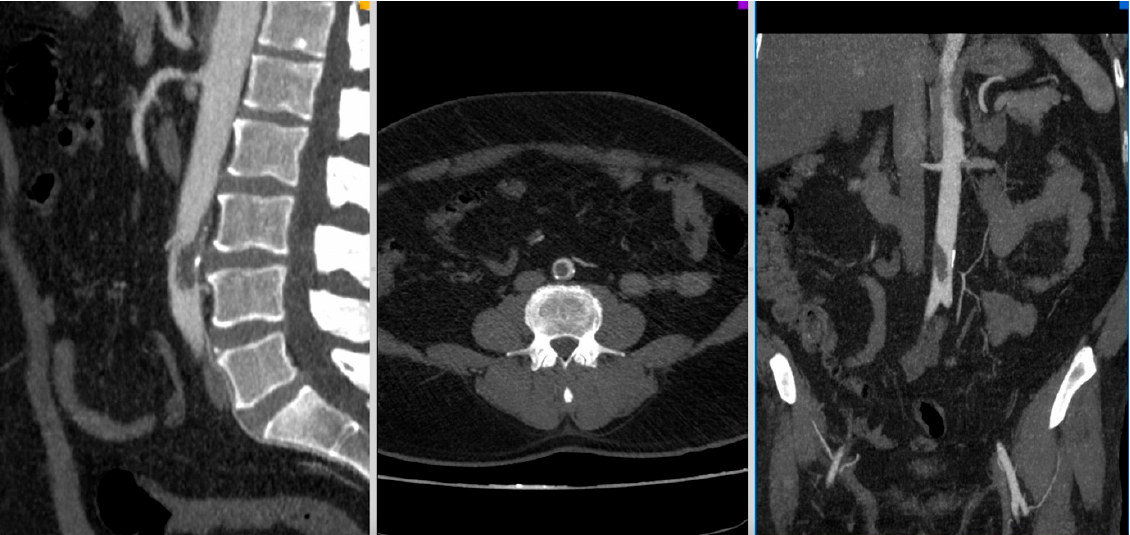
Figure 1. CT-Angio of a 52 yo patient with aortic thrombosis with acute right lower limb ischemia 8 days after SARS-CoV-2 diagnosis.